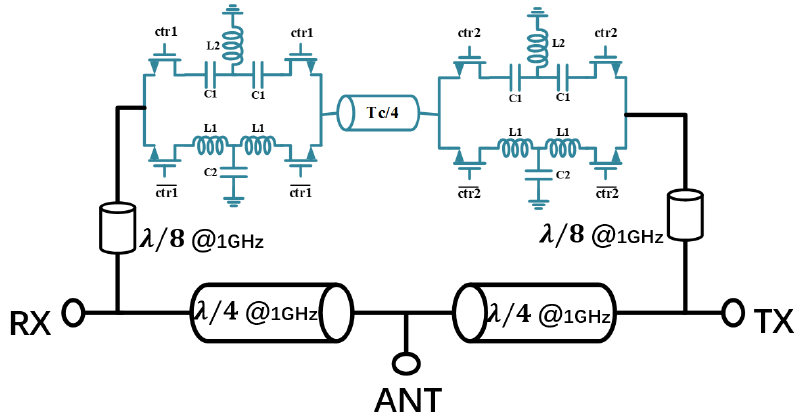
Figure 9. Circuit of the designed circulator based on the TVPM.